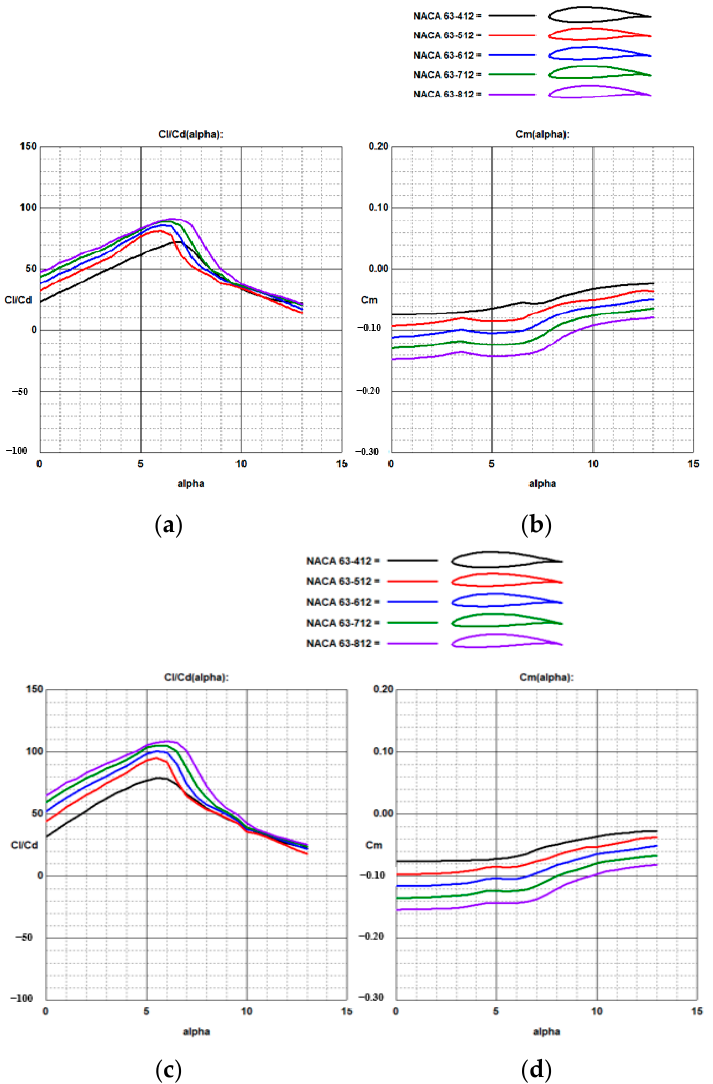
Figure 4. Comparison of lift-to-drag ratio of airfoils with different Reynolds numbers. ( a ) and ( b ) are the lift-to-drag ratio and pitch moment coefficient for Re = 2 × 10 5 , ( c ) and ( d ) are the lift-to-drag ratio and pitch moment coefficient for Re = 3 × 10 5 .